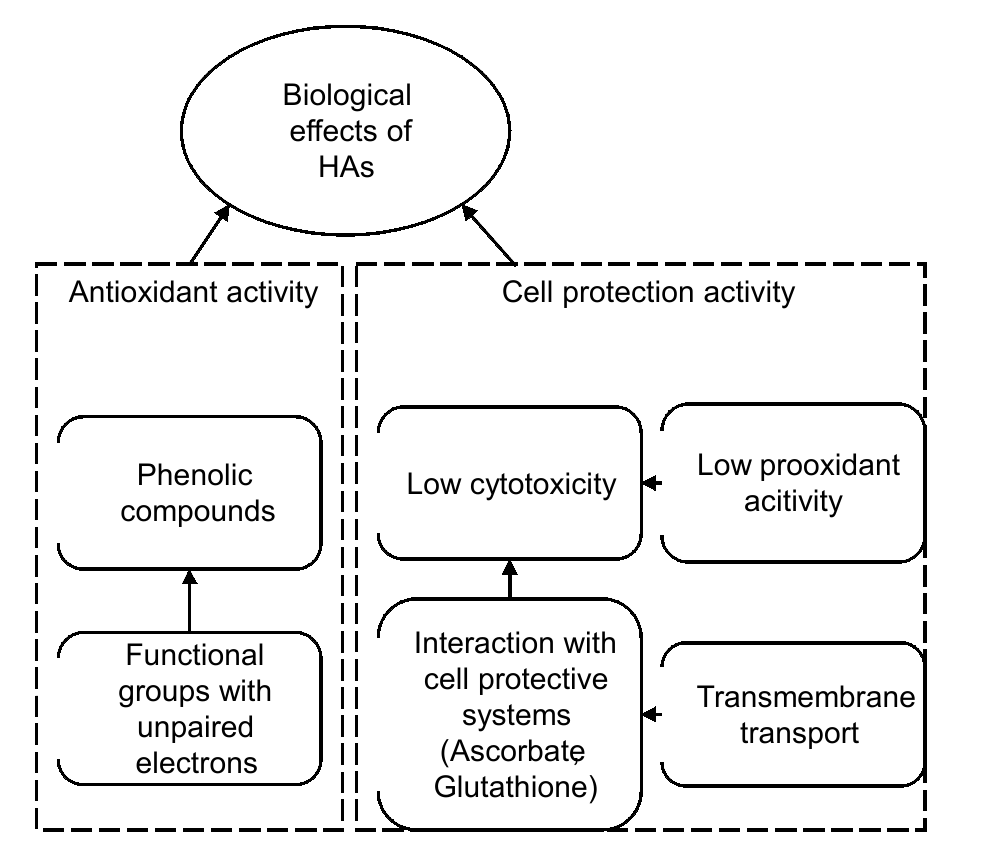
Figure 5. A hypothetical ontology-based model of biological activity of HAs.